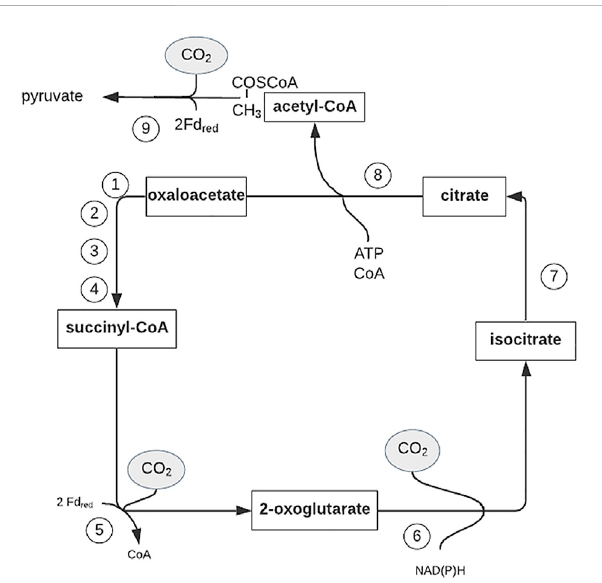
FIGURE 4 Outline of the reductive citric acid cycle for autotrophic CO 2 fi xation. Figure redrawnafter reference (Hügler et al., 2005).Boldarrows indicate the reactions catalyzed by key enzymes. Enzyme activities: 1, malate dehydrogenase (EC 1.1.1.37); 2, fumarate hydratase (fumarase) (EC 4.2.1.2); 3, fumarate reductase; 4, succinyl-CoA synthetase (EC 6.2.1.5); 5, 2-oxoglutarate:ferredoxinoxidoreductase (EC 1.2.7.3); 6, isocitrate dehydrogenase (EC 1.1.1.42); 7, aconitate hydratase (aconitase) (EC 4.2.1.3); 8, ATP citrate lyase (EC 2.3.3.8); and 9, pyruvate: ferredoxin oxidoreductase (EC 1.2.7.1); Fd red, reduced